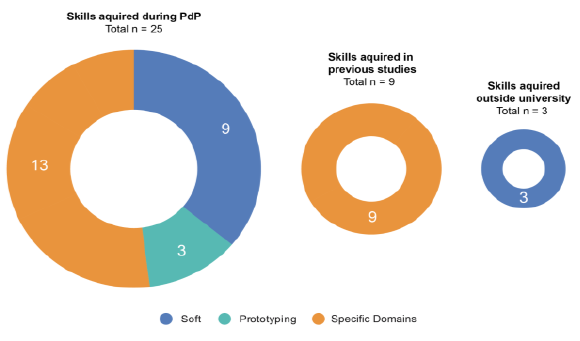
Fig. 1. Assessment of where skills were acquired Table 3. Respondents' perceived skills and where those were acquired.